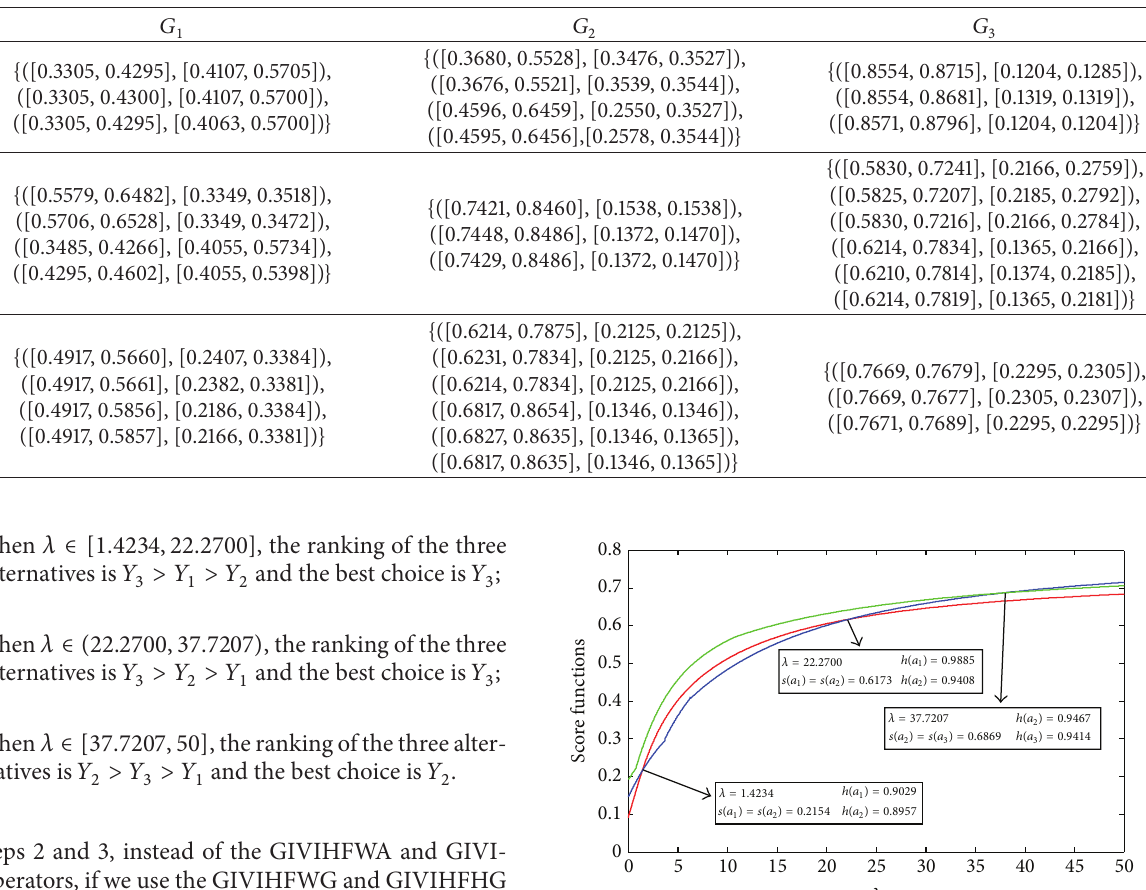
Table 8: The collective interval-valued intuitionistic hesitant fuzzy decision matrix